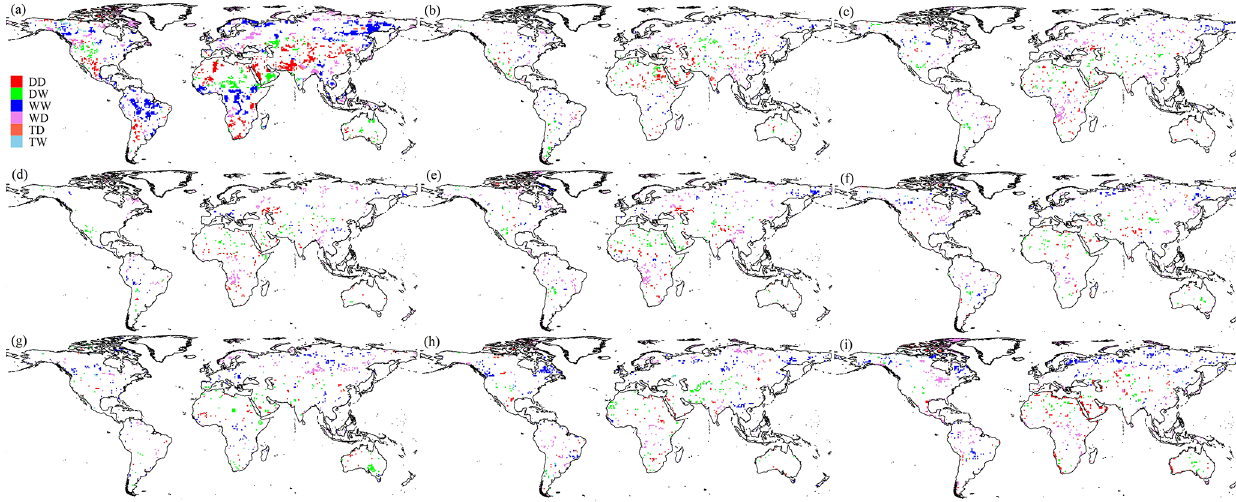
Figure 4. Global assessment of the DDWW paradigm based on P − E − R during the (a–f) historical (1985–2014) and future (2071–2100) periods under (g) SSP126, (h) SSP245, and (i) SSP585 scenarios. Note that the historical results are based on the (a) observation-based products (i.e., CRU P , GLEAM E , and G-RUN R ), (b) WGHM, (c) VIC, (d) CLSM, (e) Noah, and (f) ensemble mean of eight GCMs, respectively. The future results are based on the ensemble of eight GCMs. DD indicates the dry gets drier, DW indicates the dry gets wetter, WW indicates the wet gets wetter, WD indicates the wet gets drier, TD indicates the transition gets drier, and TW indicates the transition gets